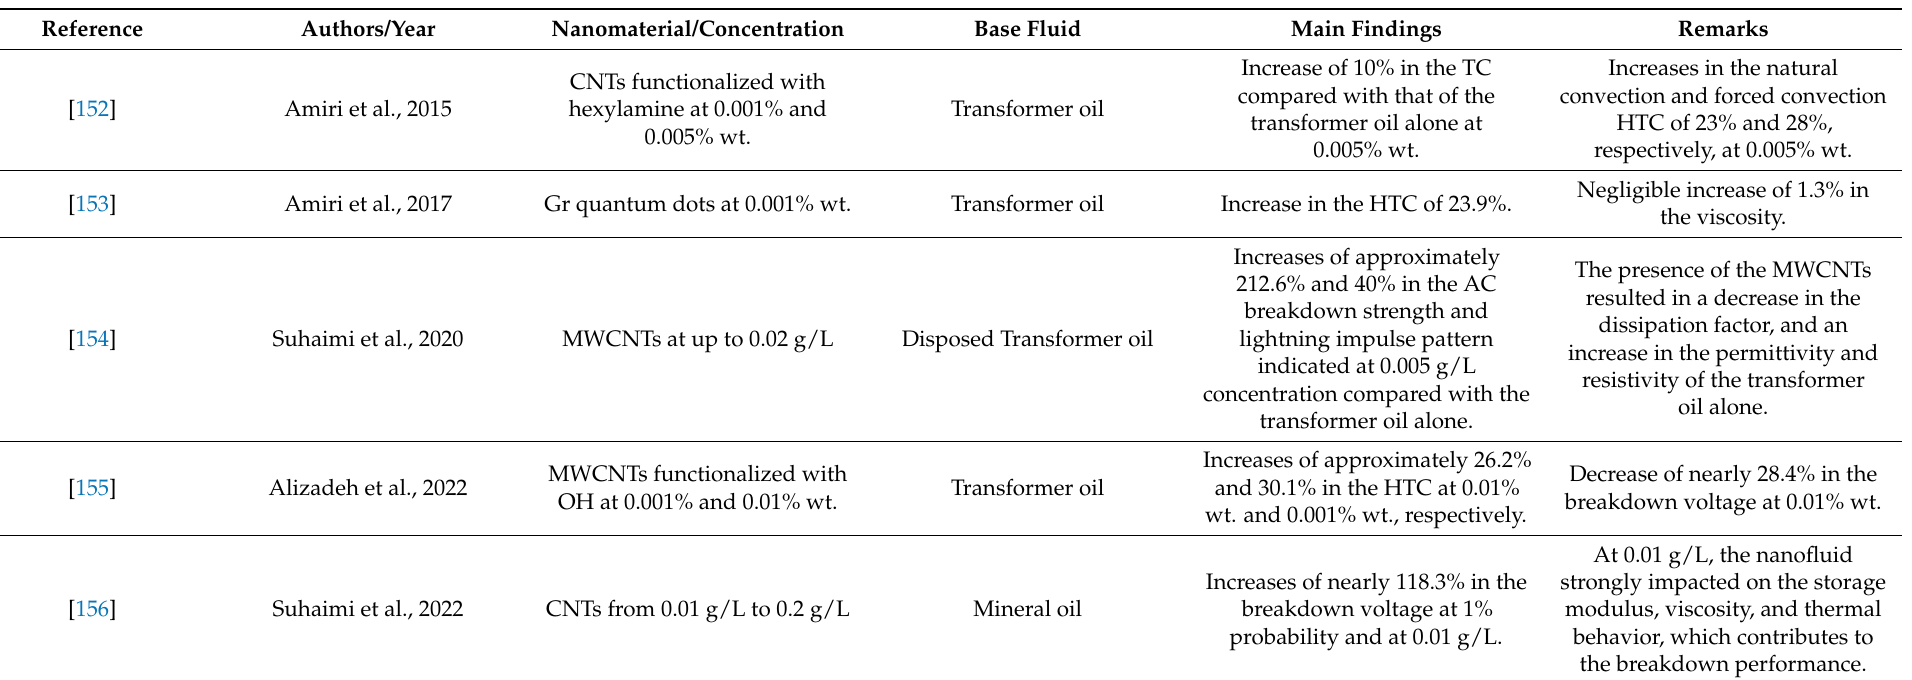
Table 10. Recent studies on the use of 2D nanofluids in electrical